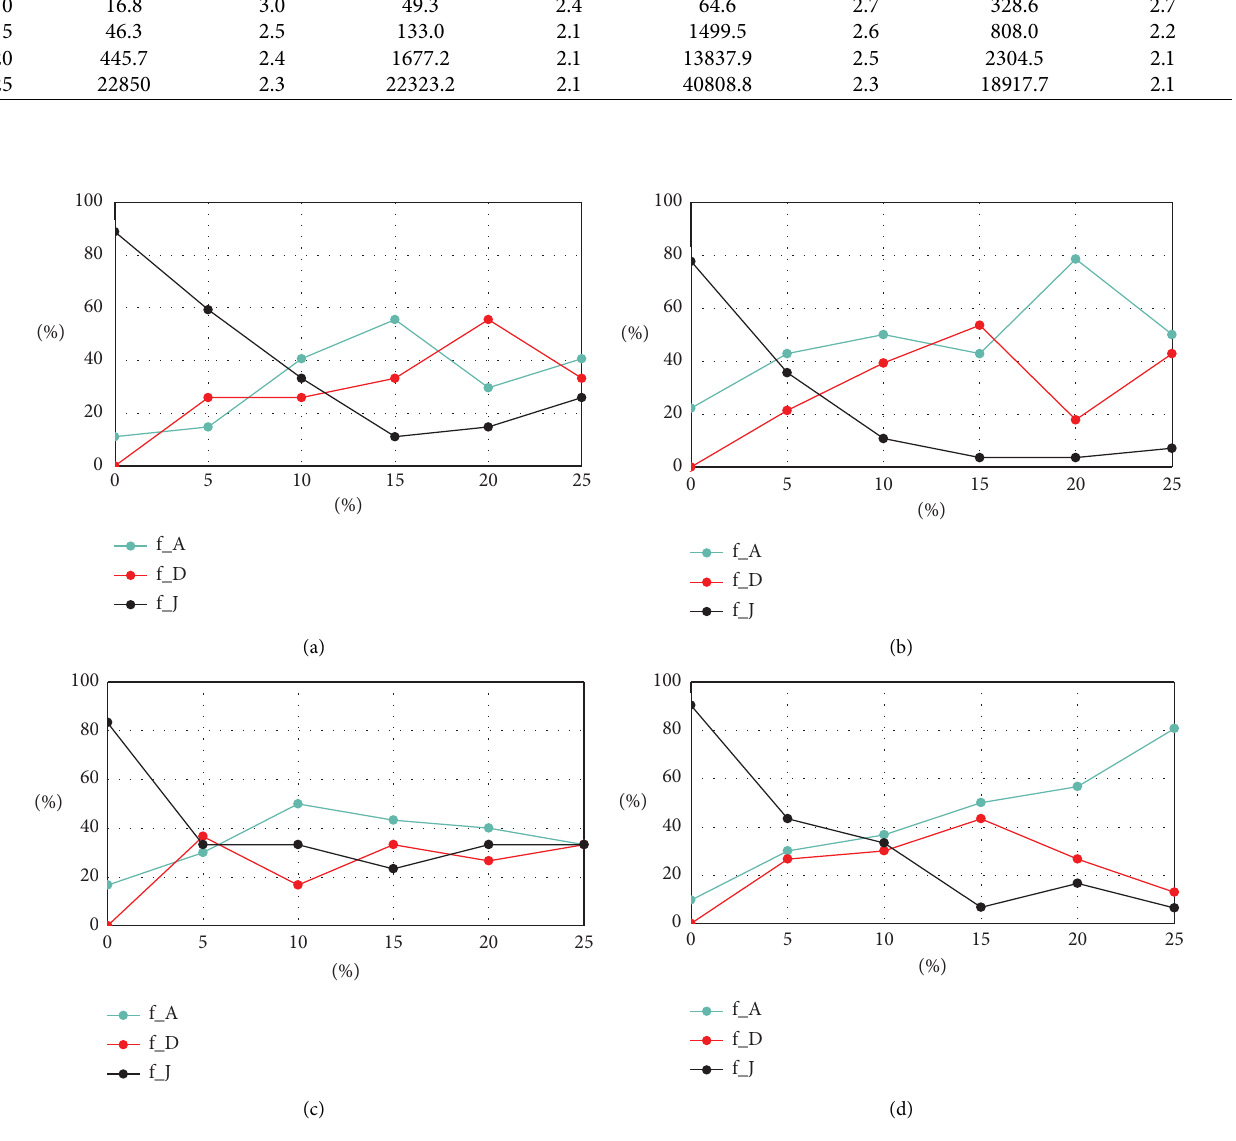
e . (a) Case study 1. (b) Case study 2. (c) Case study 3. (d) Case